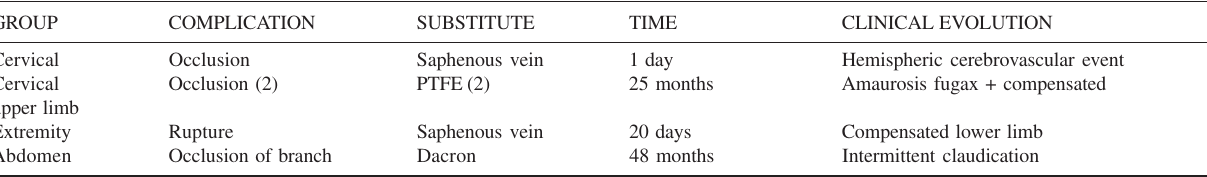
Table 2 - Arterial complications